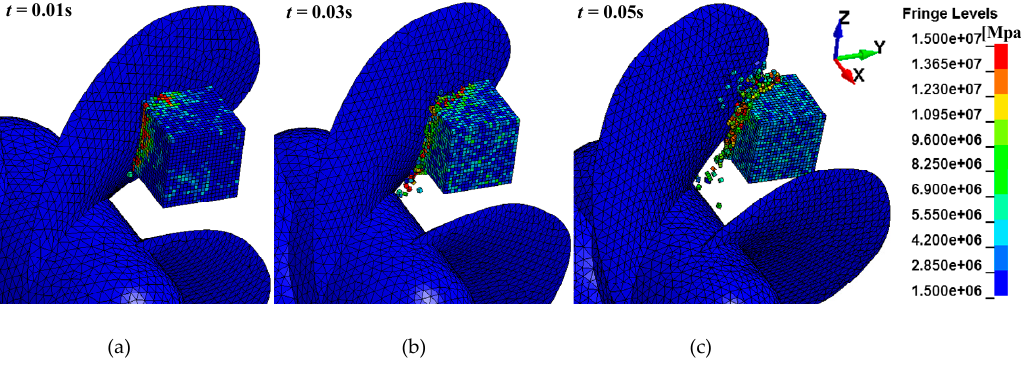
Figure 12. Stress nephograms during dynamic propeller–ice impacting process. ( a ) The ice impact simulation at 0.01s. ( b ) The ice impact simulation at 0.03s. ( c ) The ice impact simulation at 0.05s.